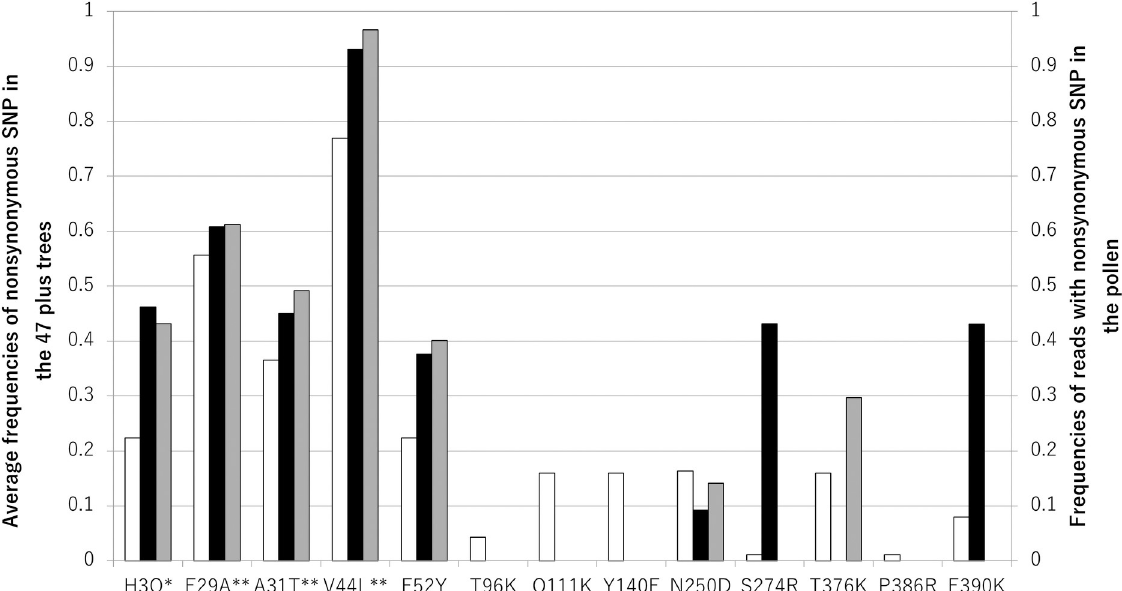
Fig 2. Comparison of frequencies for deduced polymorphic residues of Cha o 2 in plus trees from the seed orchards and those reads with nonsynonymous SNPs in Cha o 2 from pollen. Average frequencies of deduced polymorphic residues of Cha o 2 in the 47 plus trees of the seed orchards from Chiba Prefecture (open bars, left axis) were compared with those reads with nonsynonymous SNPs in Cha o 2 from pollen taken from the artificial forests in the same prefecture (closed bars, right axis) and Ibaraki Prefecture (shaded bars, right axis). � : H3Q was determined previously by N-terminal amino acid sequencing [16]. �� : E29A, A31T and V44L were reported in [15] by the deduced amino acid sequence (Q7M1E7) from cDNA.